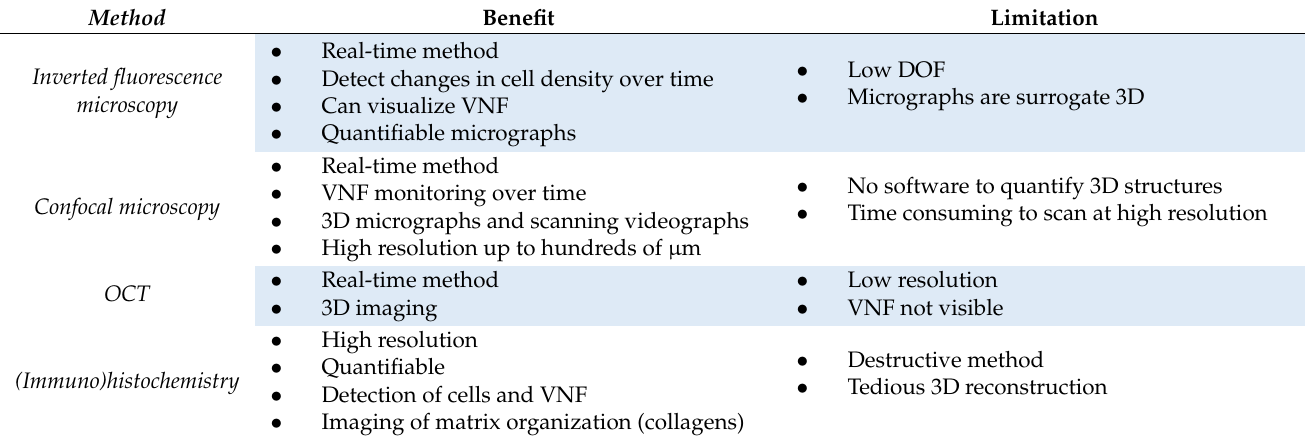
Table 1. Comparison of benefits and limitations of four methods of assessing VNF in ECM